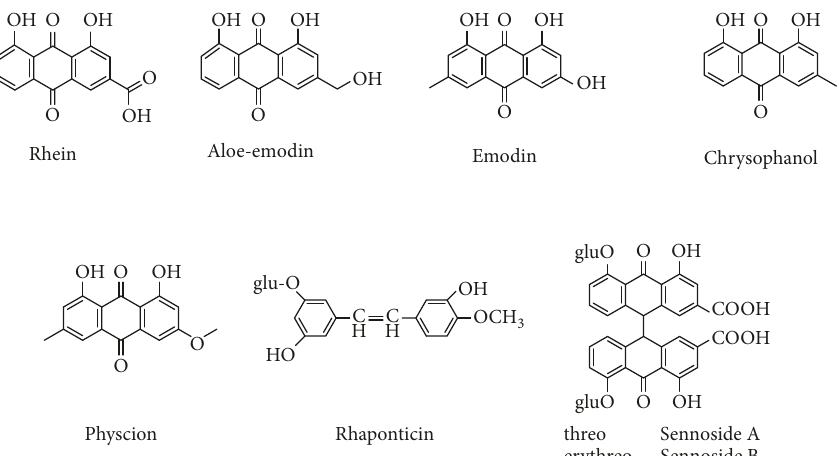
Figure 1: Chemical structures of anthraquinones and its analogues in